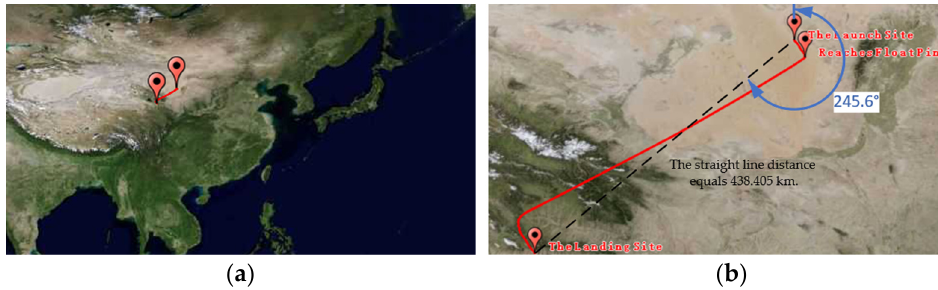
Figure 10. Trajectory of the balloon flight system. ( a ) shows the relative position of the trajectory on the world map. ( b ) shows the trajectory in detail.